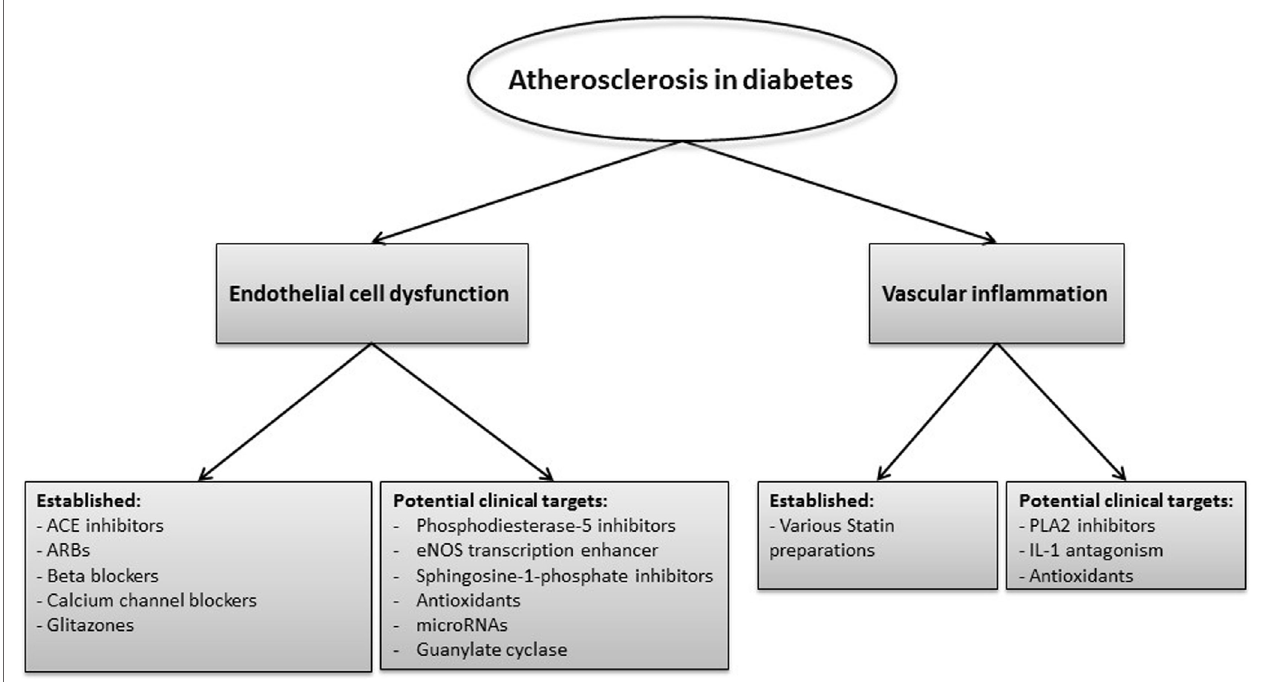
FigURe 4 | Inflammatory pathways that are currently used or may represent therapeutic targets to reduce vascular risk in diabetes. Current therapies and others in development focus on improving the endothelial cell function and reducing vascular inflammation. Established therapies to target endothelial dysfunction are angiotensin converting (ACE) inhibitors, angiotensin II-receptor blockers (ARBs), beta blockers, calcium channel blockers, and glitazones, whereas agents such as phosphodiesterase-5 inhibitors, endothelial nitric oxide synthase (eNOS) transcription enhancer, and microRNAs represent potential future therapies. Statins are widely used to reduce vascular risk and in addition to their cholesterol lowering effect they reduce vascular inflammation. Other potential targets to reduce vascular inflammation include of phospholipase A2 (PLA2) inhibitors as well as interleukin (IL)-1 antagonists and